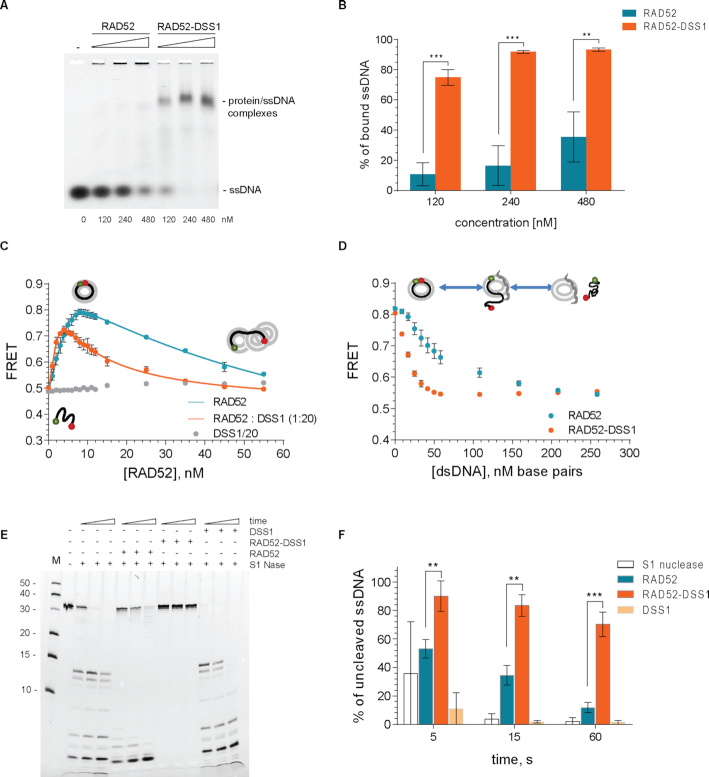
DSS1 affects the mode of the ssDNA wrapping around the RAD52 oligomeric ring. (A) EMSA with fluorescently labelled 33-mer ssDNA incubated with increasing concentration of RAD52 or preformed RAD52-DSS1 complex. Protein–ssDNA complexes and free ssDNA are indicated. (B) Quantification of three independent EMSA assays. Mean values ± SD were plotted (Welch's t-test, P < 0.01 = **; P < 0.001 = ***). (C) FRET-based binding ssDNA binding assay for RAD52 or RAD52-DSS1 (1:20) respectively. The ssDNA–RAD52 interaction changes the FRET between Cy3 and Cy5 dyes. Each data point represents average and standard deviation from three independent experiments. Continues line represent fitting of the data to two-step binding isotherm. (D) FRET-based dsDNA competition assay using linearized plasmid DNA. FRET signal decreases as ssDNA is released from RAD52 or RAD52-DSS1 due to binding of the dsDNA. The mean values ± SD from three independent experiments are plotted. (E) S1 nuclease protection assay in the presence of RAD52 or RAD52-DSS1 complex. (F) Evaluation of the percentage of uncleaved ssDNA substrate from three independent experiments using Welch's t-test, P < 0.01 = **; P < 0.001 = ***.